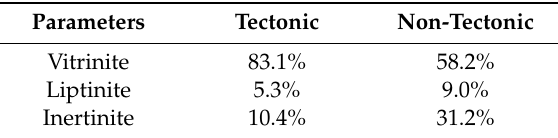
Table 2. Maceral content.